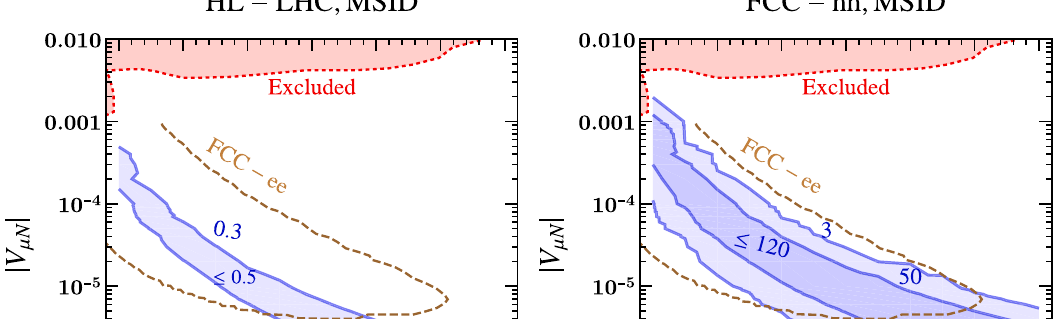
Fig. 15 As Fig. 14, but showing number of event for 1IDvx (left) and 1MSvx (right)